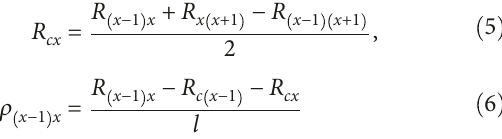
fi ngers, back busbars, and